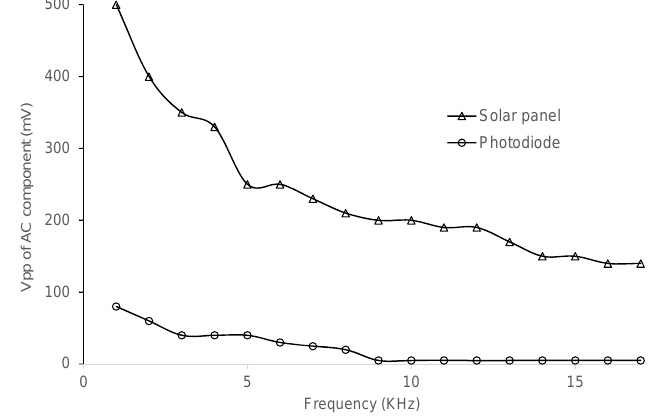
Figure 5. Response of indoor solar panel vs. photodiode to a VLC signal modulated with different frequencies.